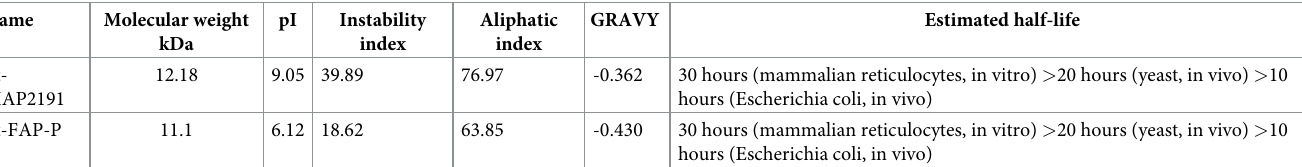
Table 5. Physicochemical characteristics of constructs.